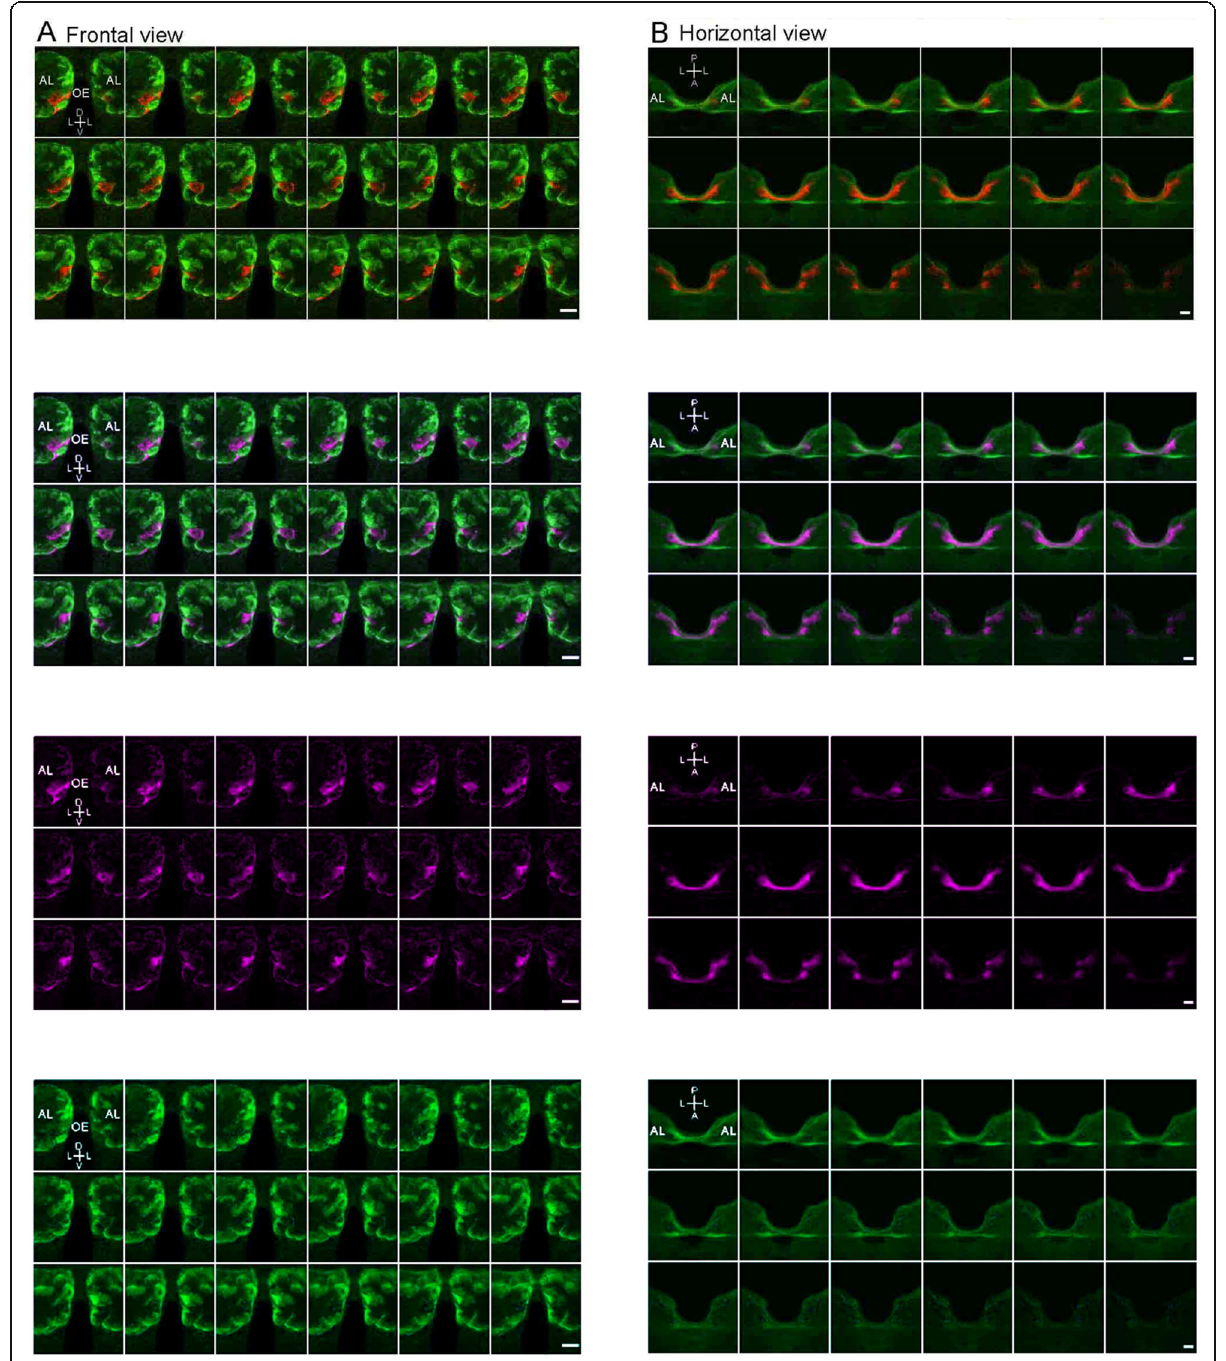
Fig. 2 Sequential confocal sections of the AL showing double labeling of ORNs from the right antenna (green or cyan) and the right maxillary palp (red or magenta). a – d Each plate indicates optical sections from anterior (upper left) to posterior (lower right) at 1.0- μ m intervals (range, 24 – 42 μ m in depth from the anterior surface of the lobe) in red-green, magenta-cyan, magenta, and cyan color schemes, respectively. e – h Each plate represents optical sections from dorsal (upper left) to ventral (lower right) at 0.55- μ m intervals in red-green, magenta-cyan, magenta, and cyan color schemes, respectively. Bars indicate 30 μ